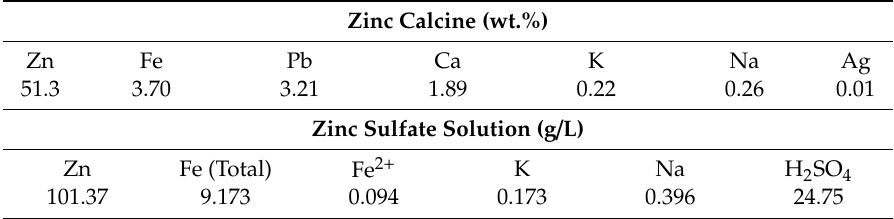
Table 1. Chemical composition of the zinc calcine and zinc sulfate